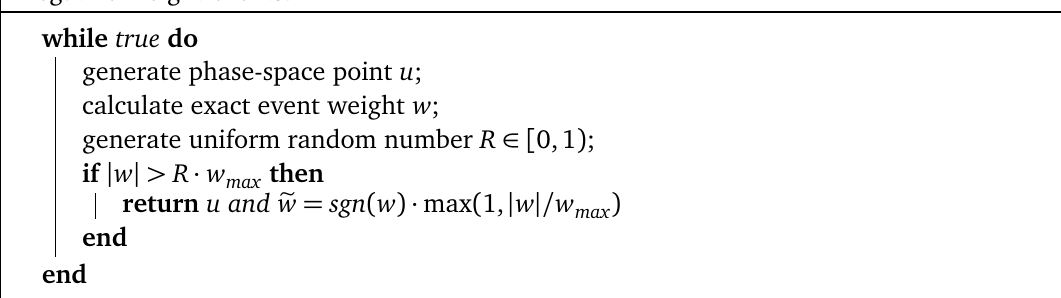
Algorithm 3: Standard rejection-sampling unweighting algorithm allowing for negative-weight